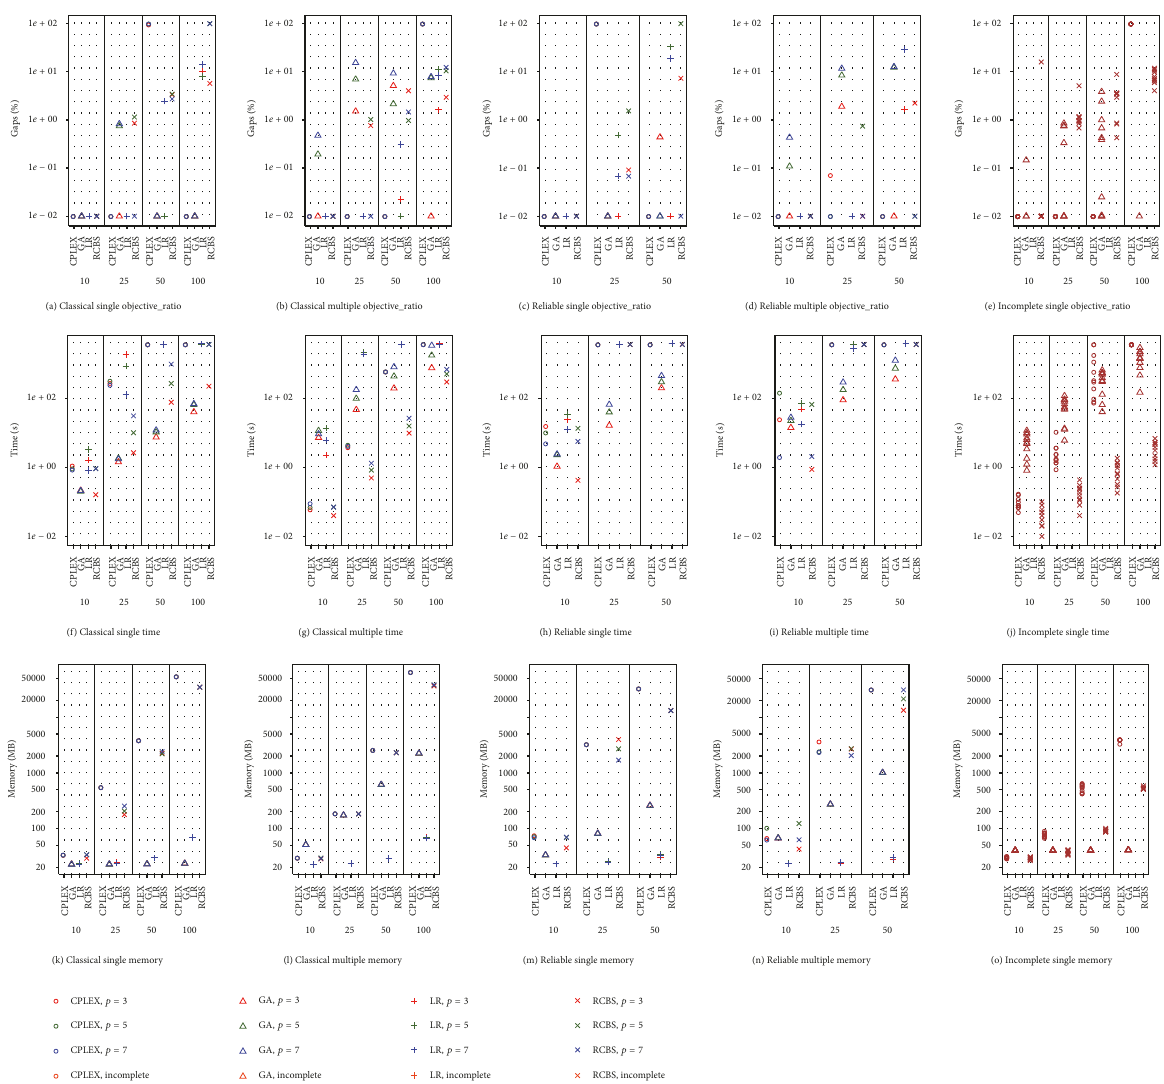
Figure 7: Results of five types of problems for AP dataset. The problems in five columns are CSA, CMA, RSA, RMA, and ISA. The measurements of three rows are solution gaps, computation time, and main memory usage, respectively. In each subfigure, the results for different numbers of nodes (𝑛 ∈ {10, 25, 50, 100}) obtained with four methods are